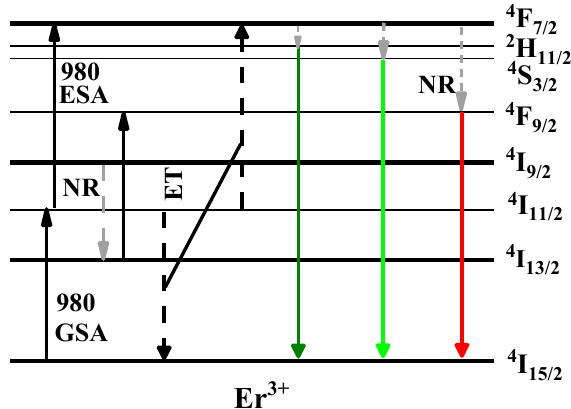
Figure 7. Energy level diagram of the crystals and possible luminescence mechanism under 980 nm excitation. Legend: ESA, excited state absorption; ET, energy transfer; GSA, ground state absorption; NR, non-radiative.